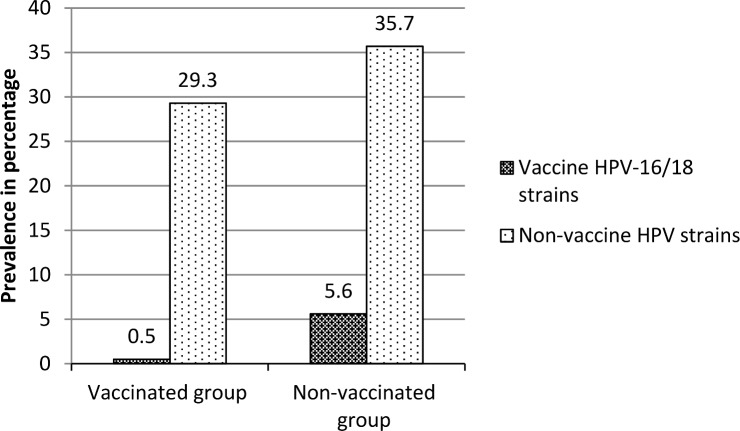
HPV genoprevalence among 15–24 year old non-vaccinated and bivalent HPV vaccinated young women in Uganda by 2014.The vaccinated group comprised of women who received the bivalent HPV 16/18 vaccine whereas the non-vaccinated group did not.